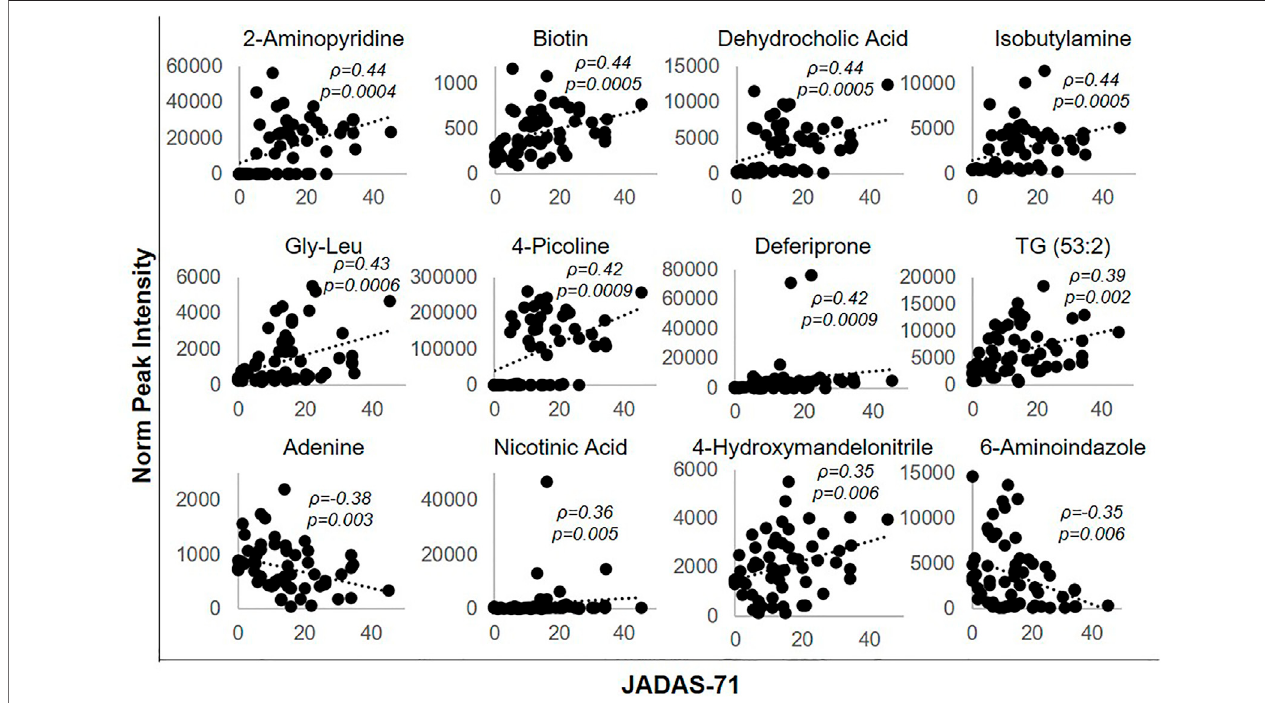
FIGURE 4 | Association of disease activity with metabolite levels over the 3-months treatment period. The normalized peak ion intensity for each of the identi fi ed metabolites was evaluated for its relationship with JADAS-71 scores by Spearman ’ s rank correlation analysis. The resulting Spearman ’ s correlation coef fi cient ( ρ ) and associated p-values are